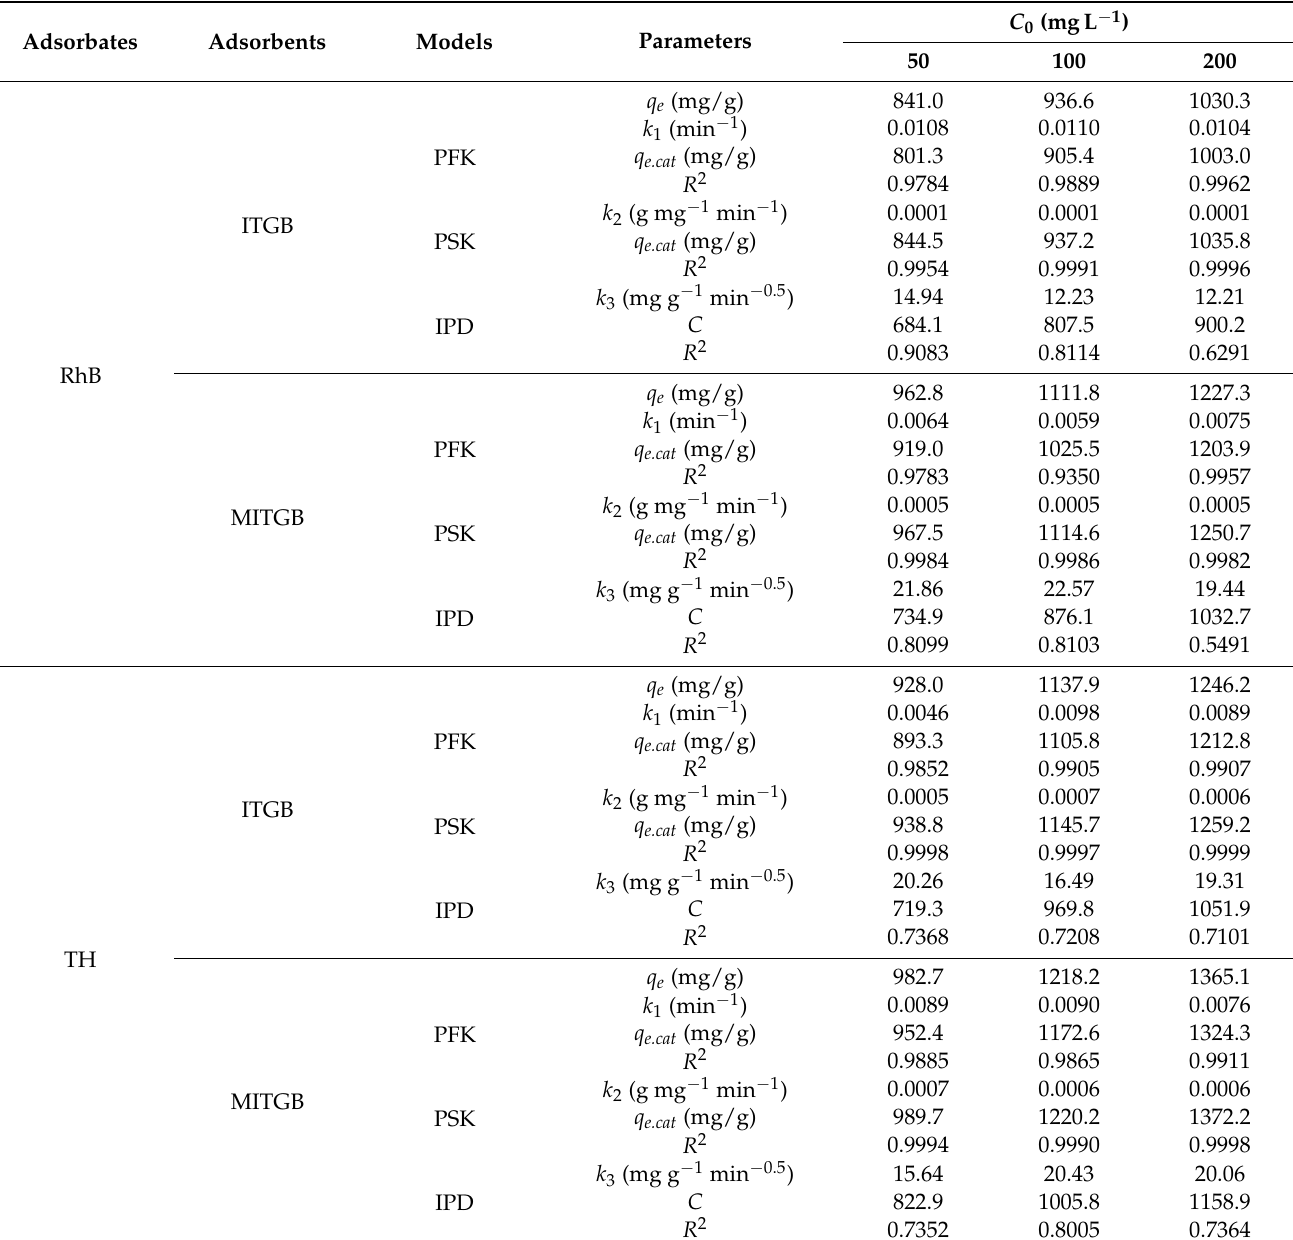
Table 2. Fitting parameters of adsorption kinetic models for RhB and TH at 303